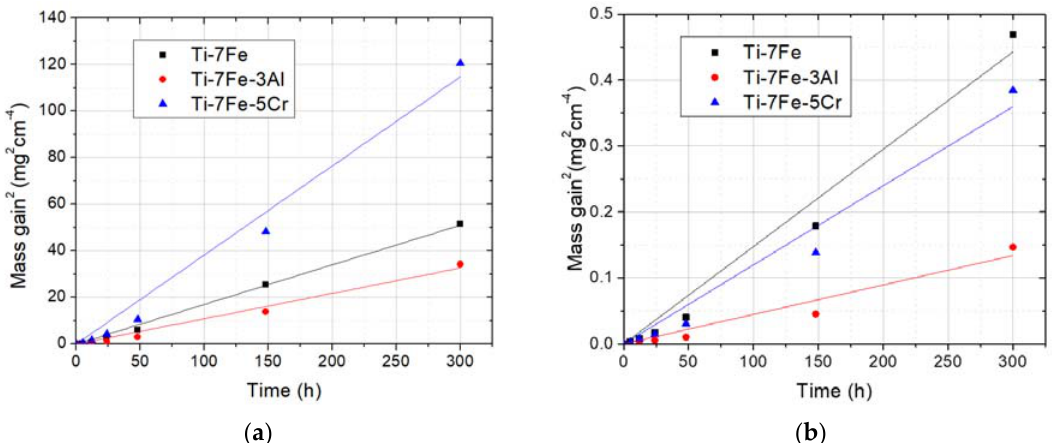
Figure 14. Wagner linearization of square of mass gain vs. time at ( a ) 600 °C ( b ) 500 °C.